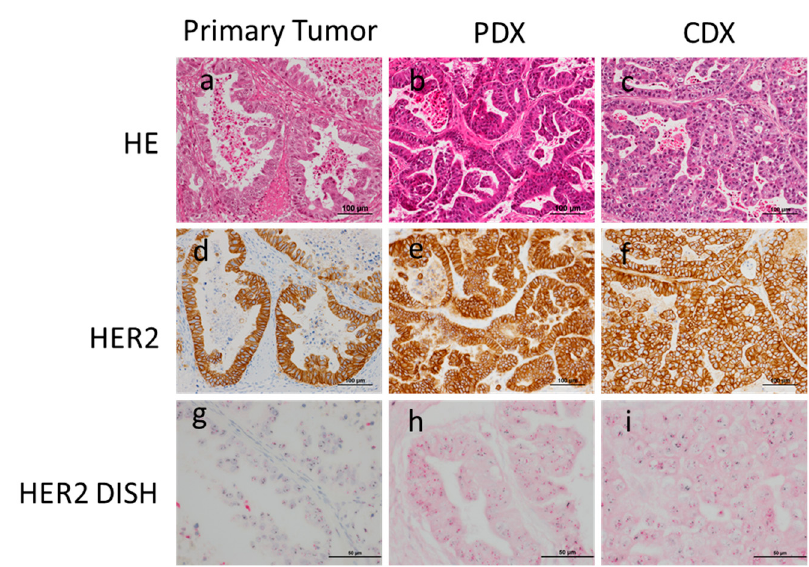
Figure 3. Histology of primary, PDX, and CDX tumors from a surgically resected specimen. ( a – c ) Primary, PDX, and CDX tumors showed similar papillary structures. ( g – i ) All tumors showed HER2 overexpression ( d – f ) as well as HER2 gene amplification. Table 3. Concordance of histological differentiation grade between Primary and PDX tumors. PDX